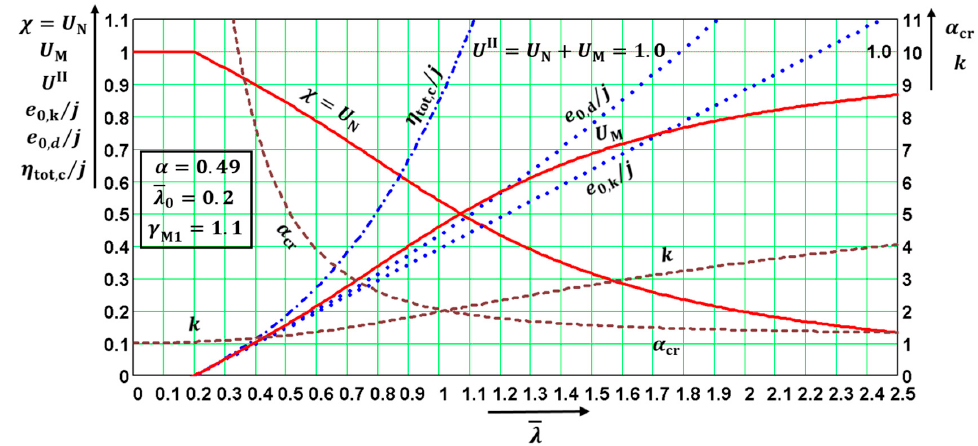
Figure 10. Relevant quantities for α = 0.49, γ M1 = 1.1, and N Ed = N b,Rd = χ Af y / γ M1 . Only Figure 10. Relevant quantities for 𝛼 = 0.49, 𝛾 (cid:2897)(cid:2869) = 1.1 , and 𝑁 (cid:2889)(cid:2914) = 𝑁 (cid:2912),(cid:2902)(cid:2914) = 𝜒𝐴𝑓 (cid:2935) 𝛾 (cid:2897)(cid:2869) ⁄ . Only quanti- Figure 10. Relevant quantities for 𝛼 = 0.49, 𝛾 (cid:2897)(cid:2869) = 1.1 , and 𝑁 (cid:2889)(cid:2914) = 𝑁 (cid:2912),(cid:2902)(cid:2914) = 𝜒𝐴𝑓 (cid:2935) 𝛾 (cid:2897)(cid:2869) ⁄ . Only quanti- Figure 10. Relevant quantities for 𝛼 = 0.49, 𝛾 (cid:2897)(cid:2869) = 1.1 , and 𝑁 (cid:2889)(cid:2914) = 𝑁 (cid:2912),(cid:2902)(cid:2914) = 𝜒𝐴𝑓 (cid:2935) 𝛾 (cid:2897)(cid:2869) ⁄ . Only quanti- quantities α cr , k , and e 0,d / j are functions of safety factor γ M1 . ties 𝛼 (cid:2913)(cid:2928) ,𝑘,and 𝑒 (cid:2868),(cid:2914) 𝑗⁄ are functions of safety factor 𝛾 (cid:2897)(cid:2869) . ties 𝛼 (cid:2913)(cid:2928) ,𝑘,and 𝑒 (cid:2868),(cid:2914) 𝑗⁄ are functions of safety factor 𝛾 (cid:2897)(cid:2869) . ties 𝛼 (cid:2913)(cid:2928) ,𝑘,and 𝑒 (cid:2868),(cid:2914) 𝑗⁄ are functions of safety factor 𝛾 (cid:2897)(cid:2869) .